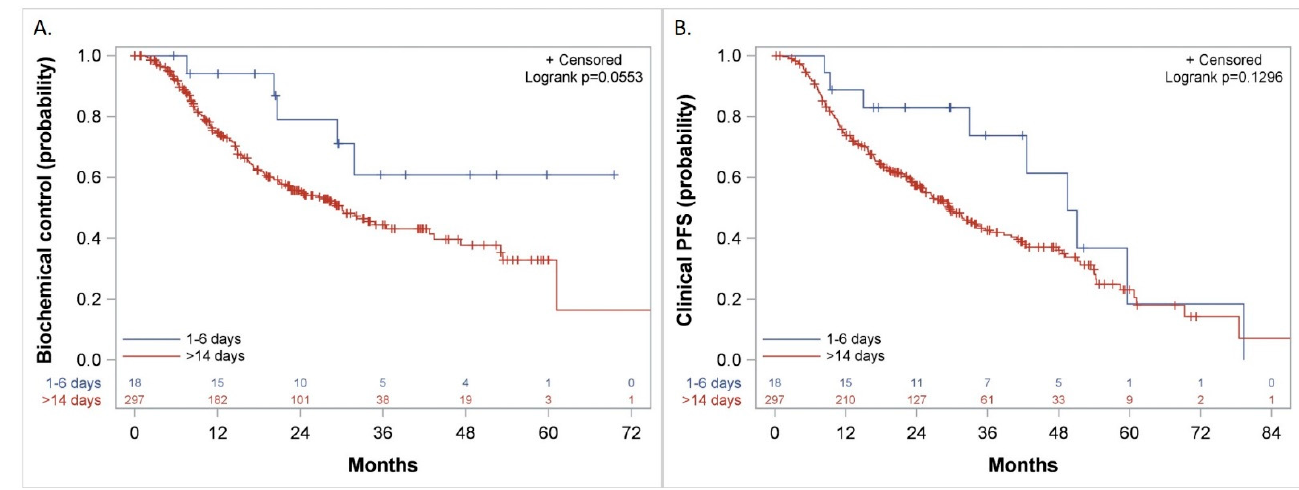
Figure 6. Kaplan–Meier curves comparing patients who started the first course of docetaxel 1–6 days versus more than 14 days after the initiation of LHRH agonist for: ( A ). Biochemical Control, ( B ). Clinical Progression ‐ Free Survival (PFS).